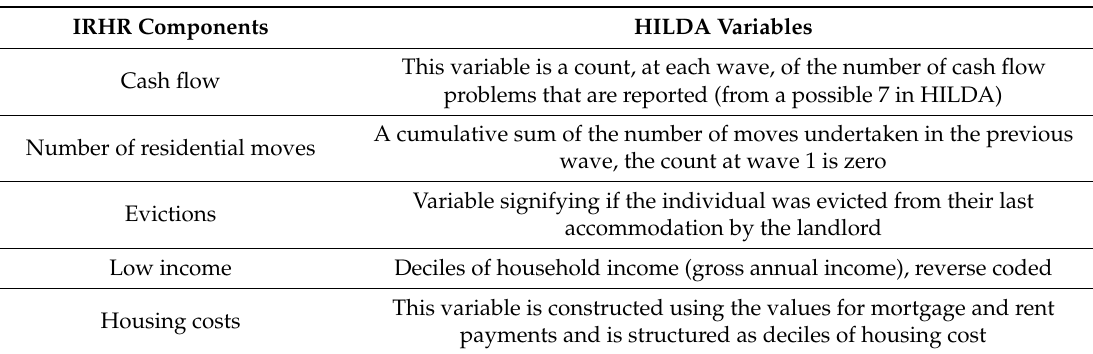
Table 1. Index of Relative Homelessness Risk (IRHR) components from the Household, Income and Labour Dynamics (HILDA) survey dataset (adapted from Beer et al., 2019